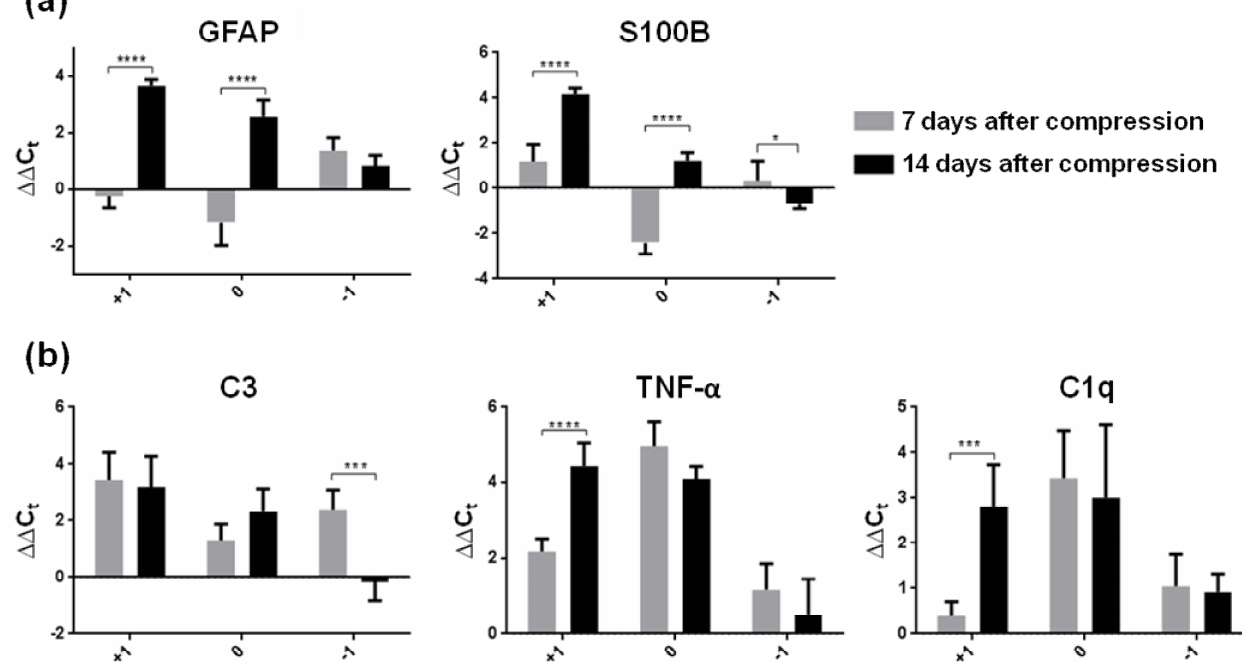
Figure 2. ( a ) Relative expression of common reactive astrocyte genes (GFAP and S100B) in the spinal cord segments (site of the injury, cranially and caudally) one and two weeks after Th9 compression. Gene expression of both markers was strongly up-regulated mainly at the injury site and adjacent cranial segments two weeks after SCI. ( b ) Expression of genes (C3, TNF- α and C1q) induced by neurotoxic A1 reactive astrocytes one and two weeks after Th9 compression. Data are mean values of five experiments ± SD. The mRNA levels for each marker were normalized to the mRNA levels of 18sRNA and expressed as ∆∆ C t values relative to controls. Results were statistically evaluated using unpaired t -test; * p < 0.05; *** p ˂ 0.001; **** p ˂ 0.0001. GFAP—Glial fibrillary acidic protein; S100B—Calcium-binding protein B; C—Complement 3;